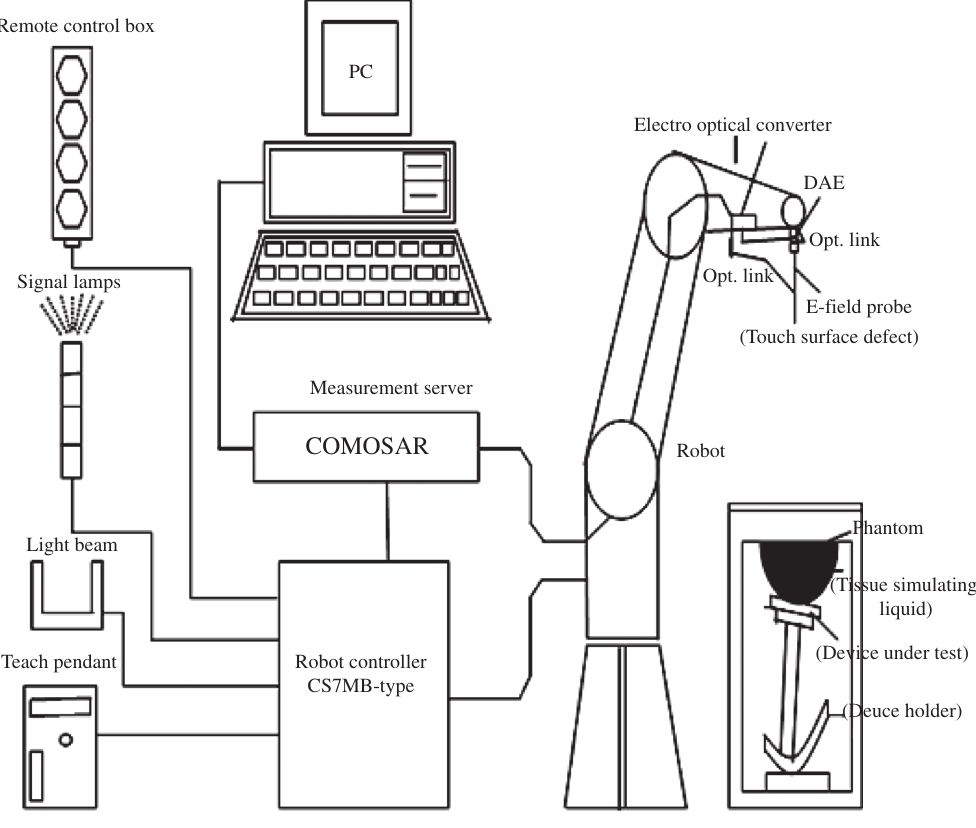
Figure 4 Experimental measurement instruments for SAR calculation.